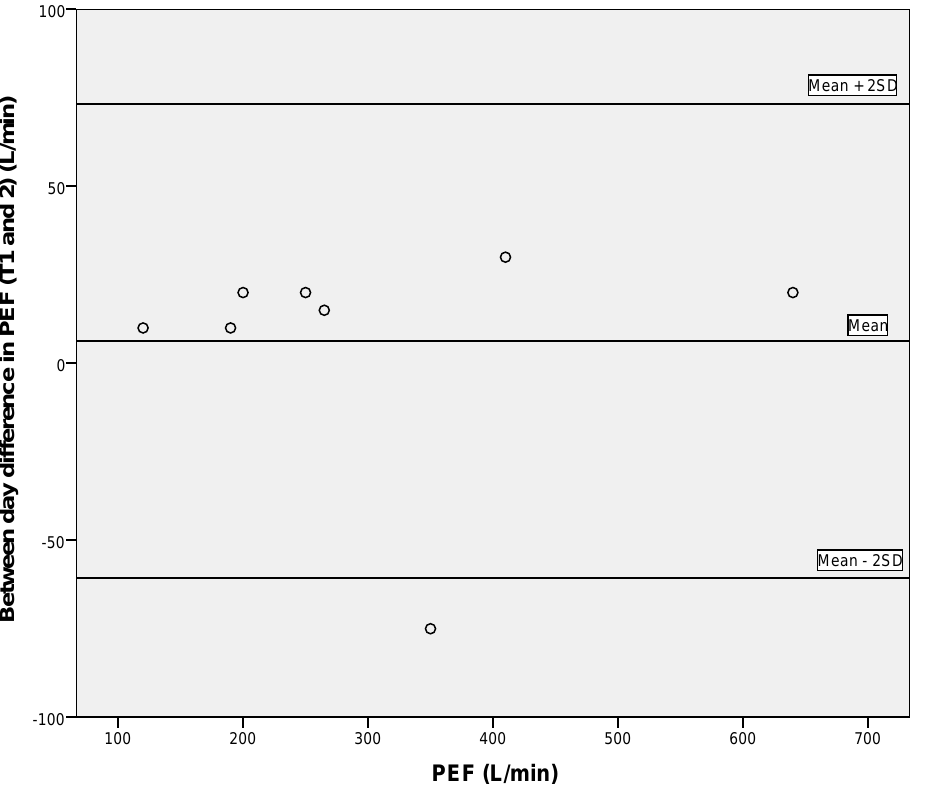
Figure 1. Bland–Altman plot showing between day variation for peak inspiratory flow (PIF).